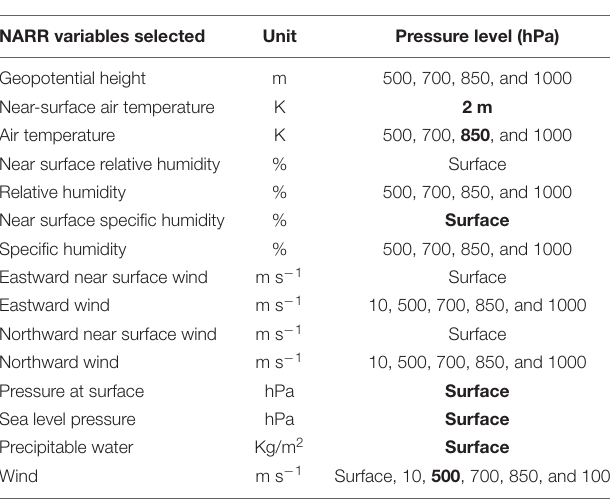
TABLE 1 | A list of NARR variables selected as predictors for